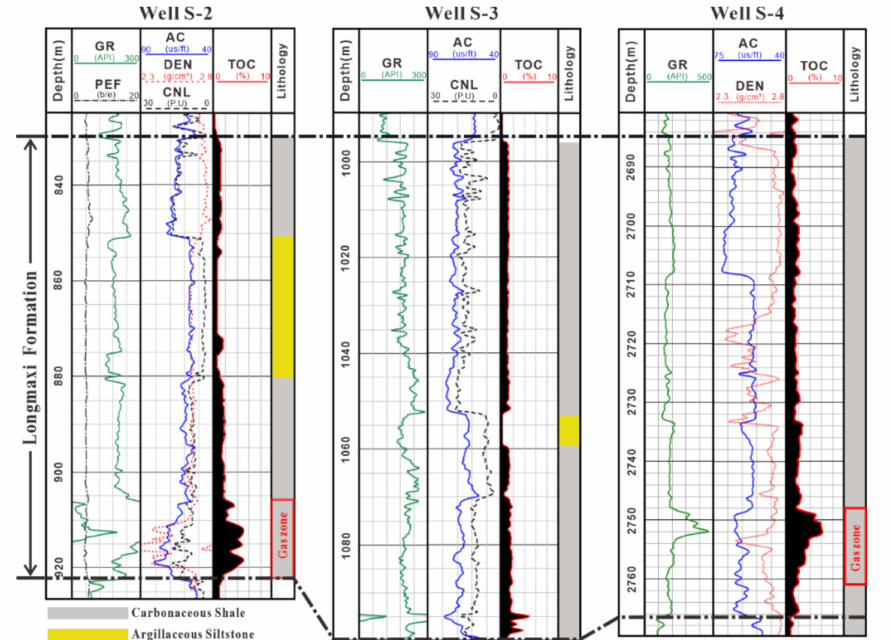
Figure 2. Logging data of wells S-2 ( left ), S-3 ( middle ) and S-4 ( right ). GR is the natural gamma curve, AC is the acoustic time difference curve, DEN is the density curve, CNL is the compensated neutron logging curve, PEF is the photoelectric absorption cross-section index curve, and TOC is the total organic carbon curve. The black dotted lines represent the interfaces of Longmaxi Formation, and the red rectangles denote the gas